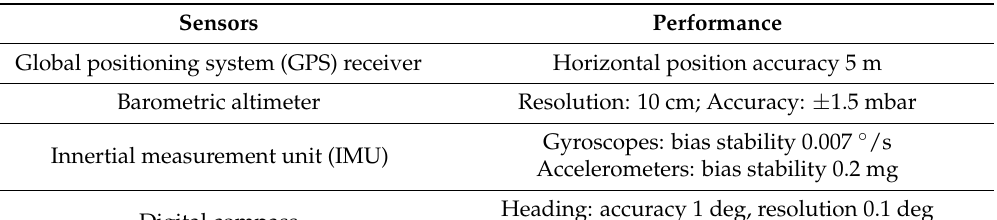
Table 2. Specifications of the positioning and orientation